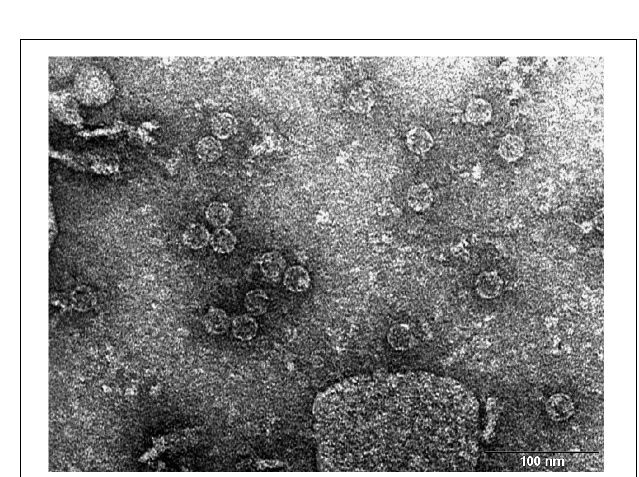
FIGURE 1 | Sodium dodecyl sulfate-polyacrylamide gel electrophoresis (SDS-PAGE – left part of the picture) and Western blot (right part of the picture) results. 1,6, E. coli BL21 (DE3) negative control; 2,5, IPTG-non-induced culture; 3,4, IPTG-induced culture. 13 kDa MS2 coat protein was massively produced in the IPTG-induced culture. M, marker Spectra multicolor broad range protein ladder (Fermentas), the marker values are in